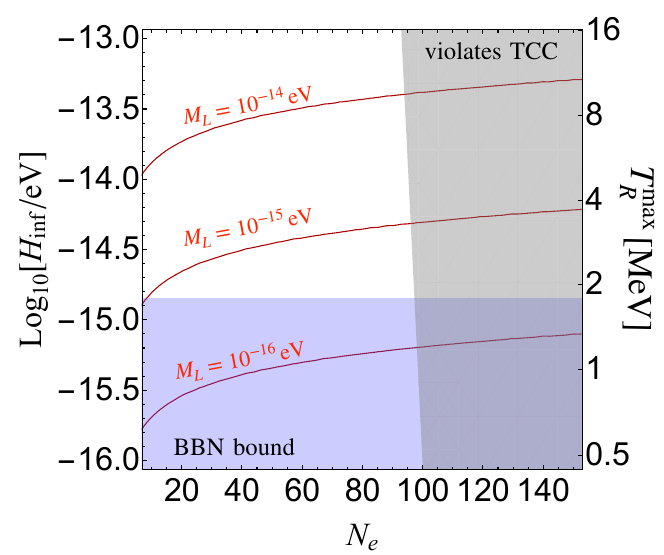
Figure 2 . Ultra-low-scale inflation in N e − H inf plane. Contours have Ω L h 2 = 0 . 12 for different values of the lightest axion mass M L = 10 − 14 , 10 − 15 , 10 − 16 eV shown from top to bottom. The maximum reheating temperature is shown on the right hand y -axis, and BBN thus gives a lower bound on H inf , shown in blue. The gray shaded region is inconsistent with the